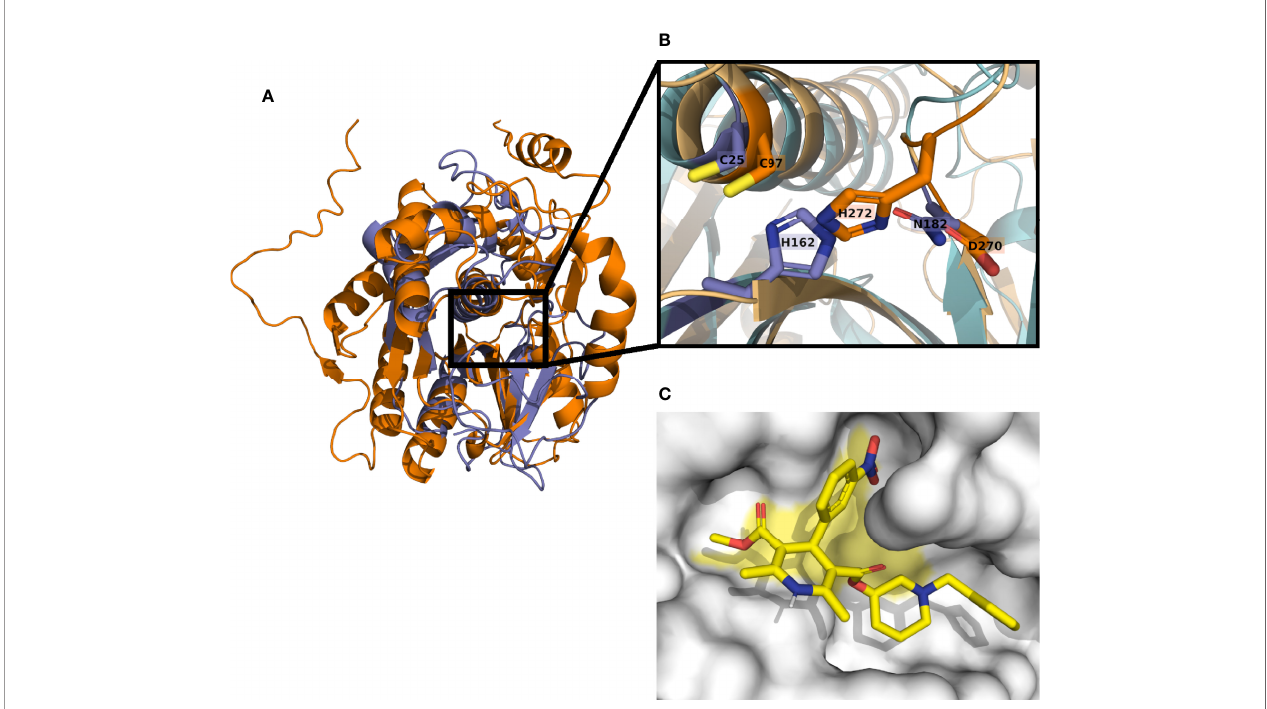
FIGURE 5 | T. cruzi cysteine peptidase Q4D5K1 model aligned with cruzipain structure 4PI3. Structural similarities can be appreciated between cruzipain (blue) and the cysteine peptidase Q4D5K1 (orange) (A) . The catalytic triad in cruzipain is composed by residues C25-H162 -N182, and aligns with the putative catalytic triad C97-H272-D270 of the cysteine peptidase (B) . Docking predictions show benidipine (yellow) binding in the catalytic site (yellow area) of the cysteine peptidase (C)